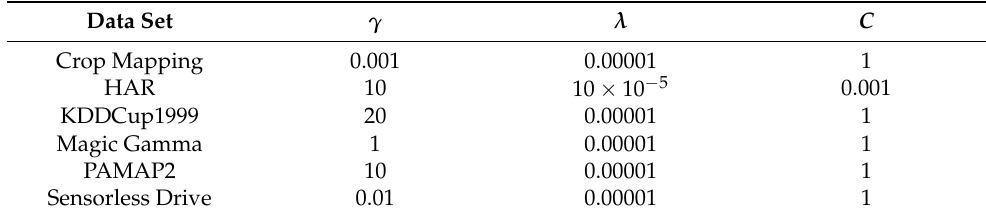
Table 2. Hyperparameter settings for manifold regularization